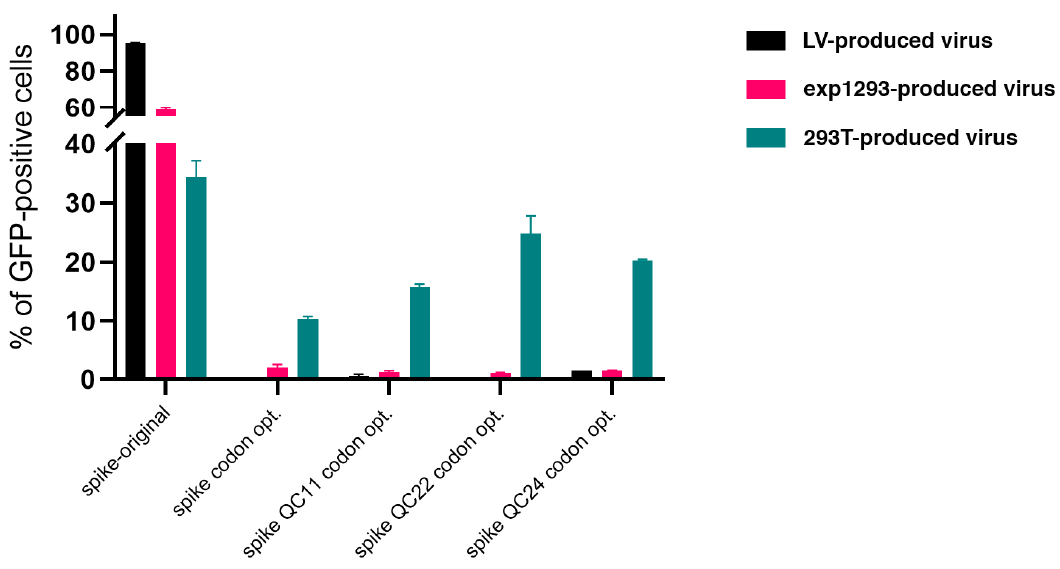
Figure 10. Quantification of GFP expression by cytometry in Vero E6 cells following lentiviral infection. Error bars indicate the standard deviation. Table 1. Correlation between qPCR and p24 results for the constructs and %GFP-containing infected cells.